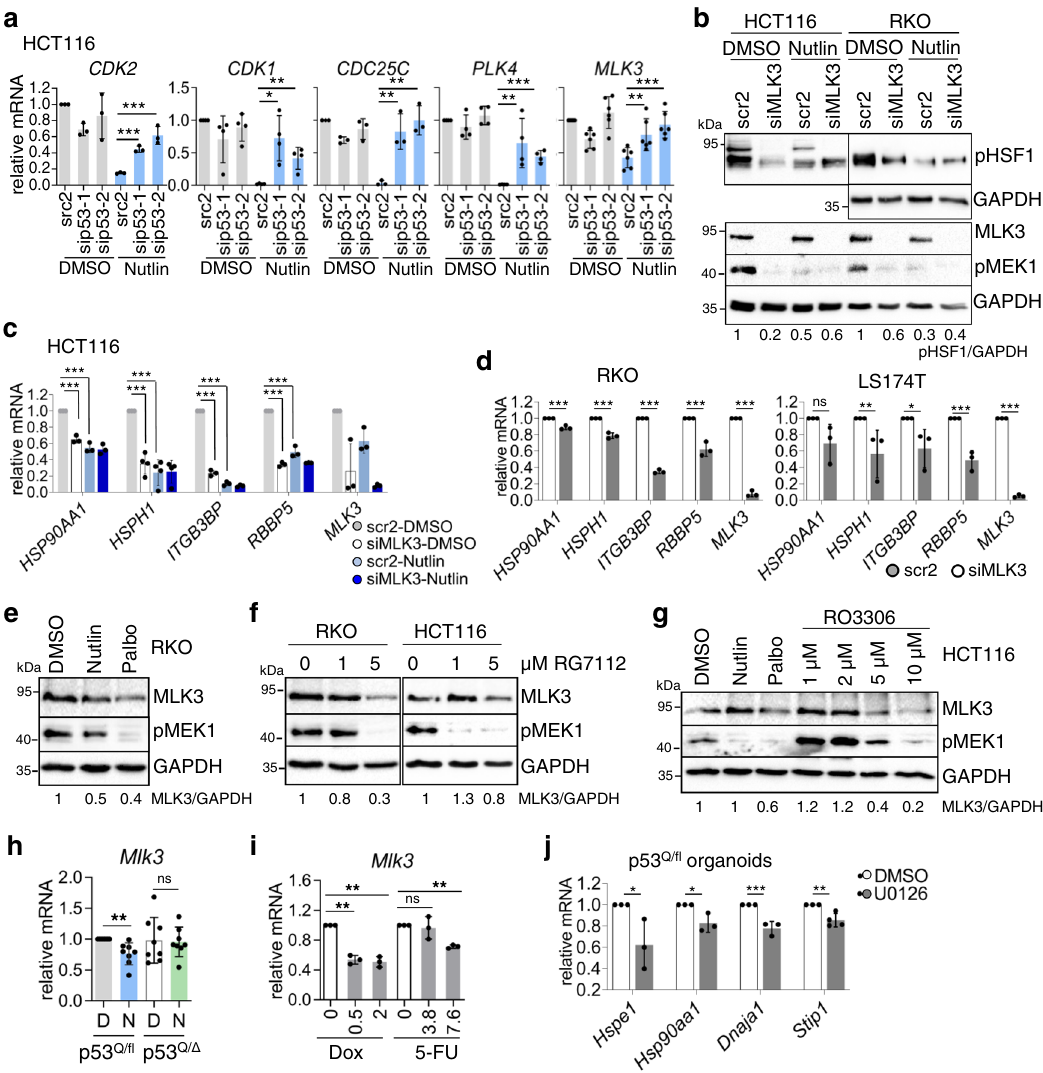
Fig. 5 MLK3 links cell cycle to the MAPK stress pathway to activate the HSF1 response. WTp53 activation represses MLK3. a The expression of cell cycle progression genes is inhibited by p53 activation. HCT116 cells were transfected with siRNAs for p53 or scrambled control siRNA (scr2) for 48h, followed by DMSO or 10 µ M Nutlin treatment for 24h. qRT-PCRs for the indicated mRNAs normalized to RPLP0 mRNA. MLK3 mixed lineage kinase 3, PLK4 polo-like kinase 4. b MLK3 silencing suppresses pSer326-HSF1, mimicking the effect of p53 activation. The indicated cells were transfected with an siRNAs pool against MLK3 or scrambled control siRNA (scr2). Forty-eight hours post transfection, cells were treated with DMSO or 10 µ M Nutlin for 24h. Immunoblot analysis. GAPDH, loading control. c MLK3 silencing abrogates HSF1 target gene expression, mimicking the effect of p53 activation. HCT116 cells